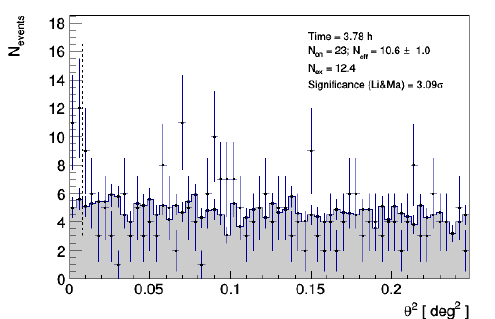
Figure 10. GRB 160821B: angular distance distribution θ 2 between the nominal source position and the reconstructed event arrival directions. The gray histogram represents the background events, while the black points with blue crosses are the γ -like events. The vertical dashed line marks the θ 2 cut value and defines the region in which excess events and signal significance are calculated. From [145]. ©AAS. Reproduced with